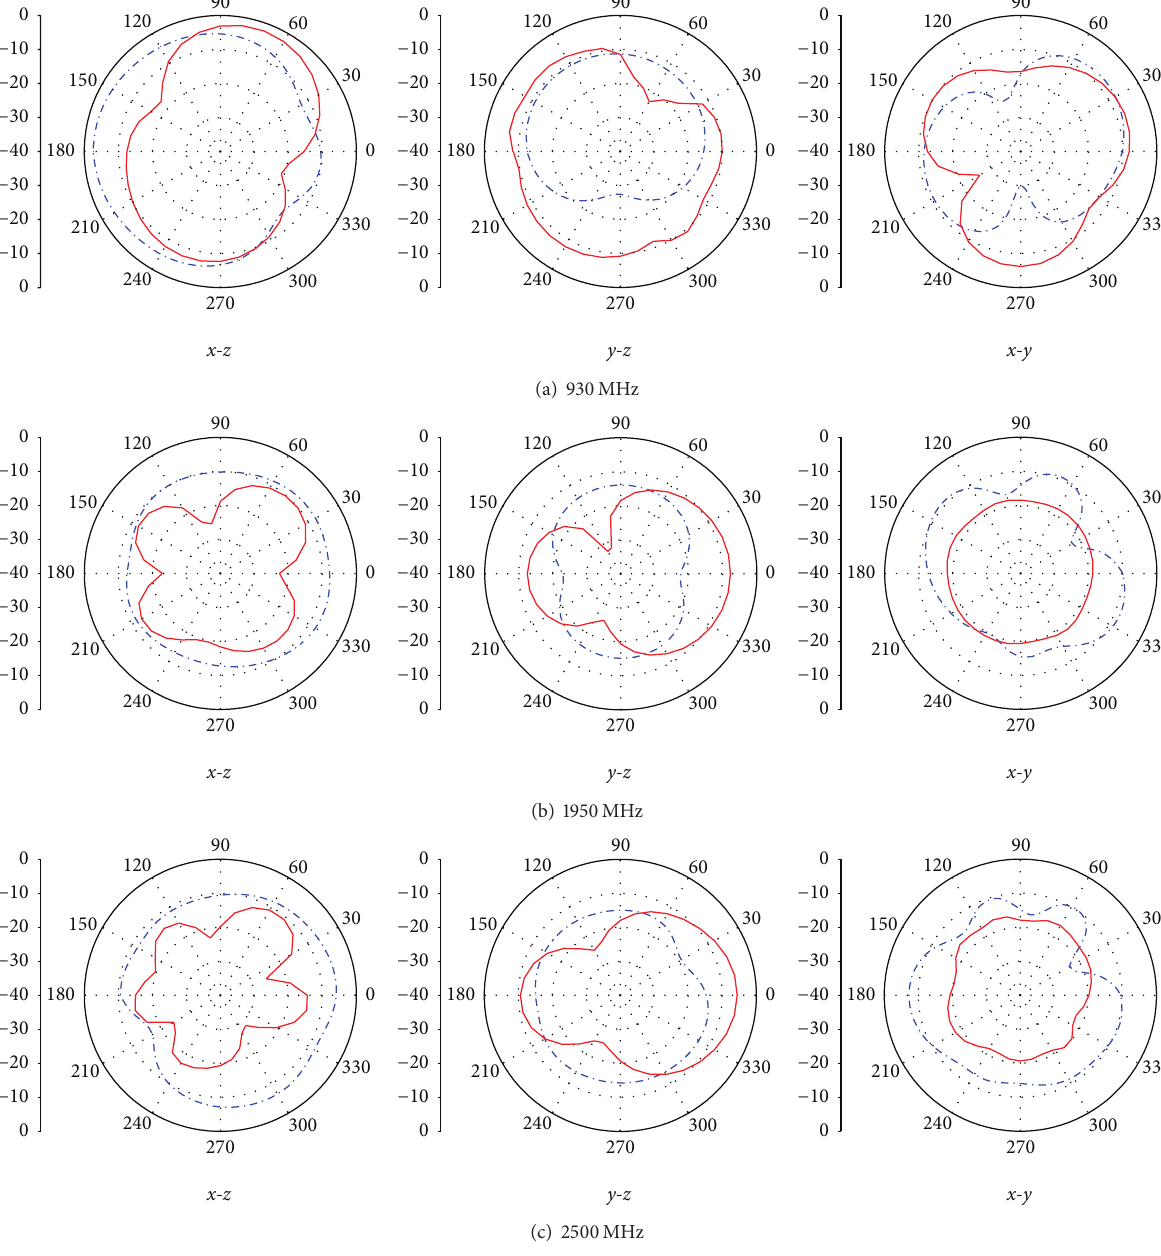
Figure 6: Measured normalized 2D radiation patterns: (a) 930 MHz, (b) 1950 MHz., and (c) 2500 MHz of the proposed dual-feed PIFA (--- 𝐸 𝐸 𝜑 , — 𝜃